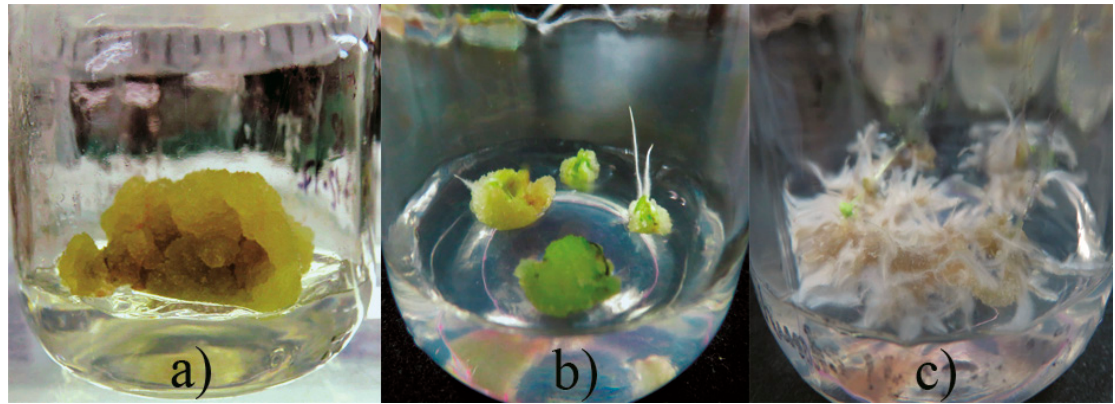
Figure 1. Effect of plant growth regulators on callus induction. ( a ) callus, ( b ) callus with roots, ( c ) roots.